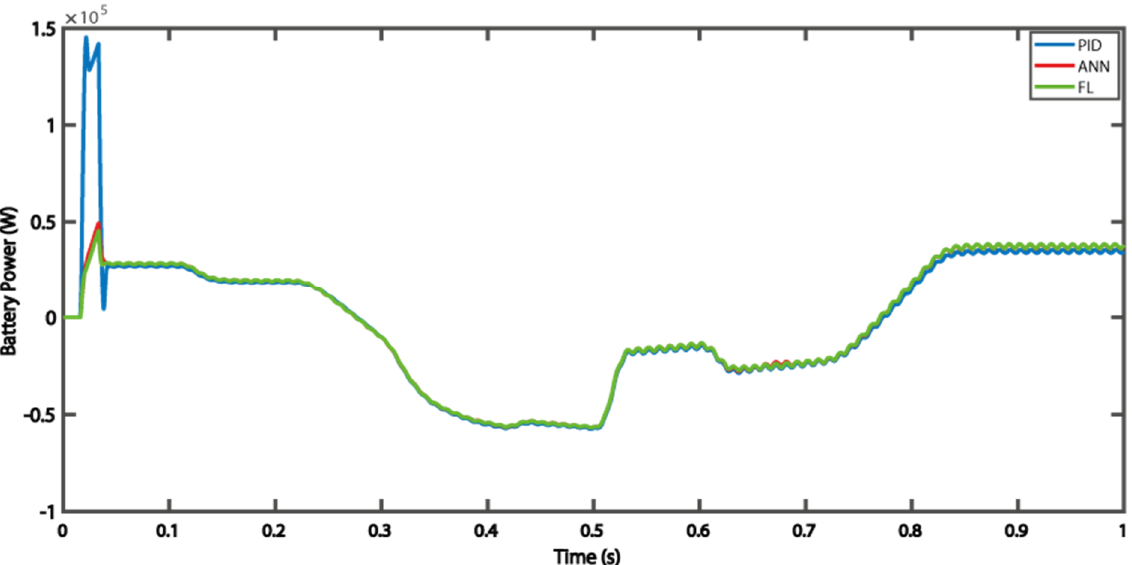
Figure 19. Variation in battery power (W).